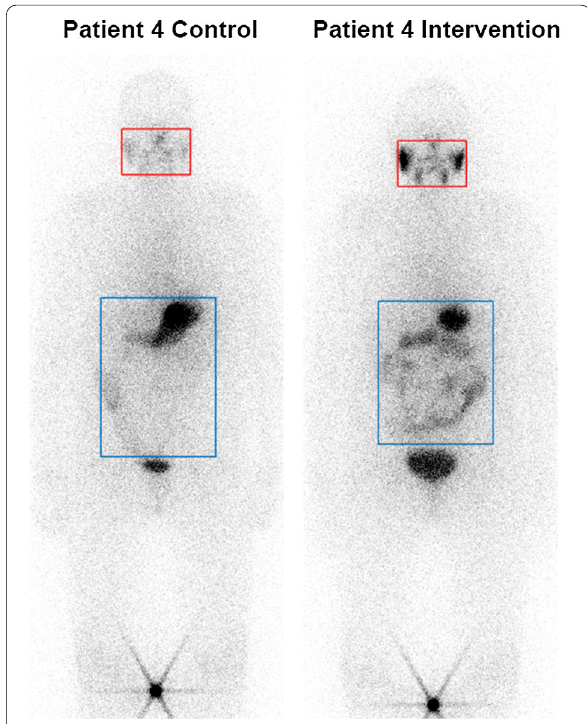
Fig. 2 Control and intervention 123 I planar scans of patient 4. An increase in uptake in the salivary glands is clearly visible on the intervention scan